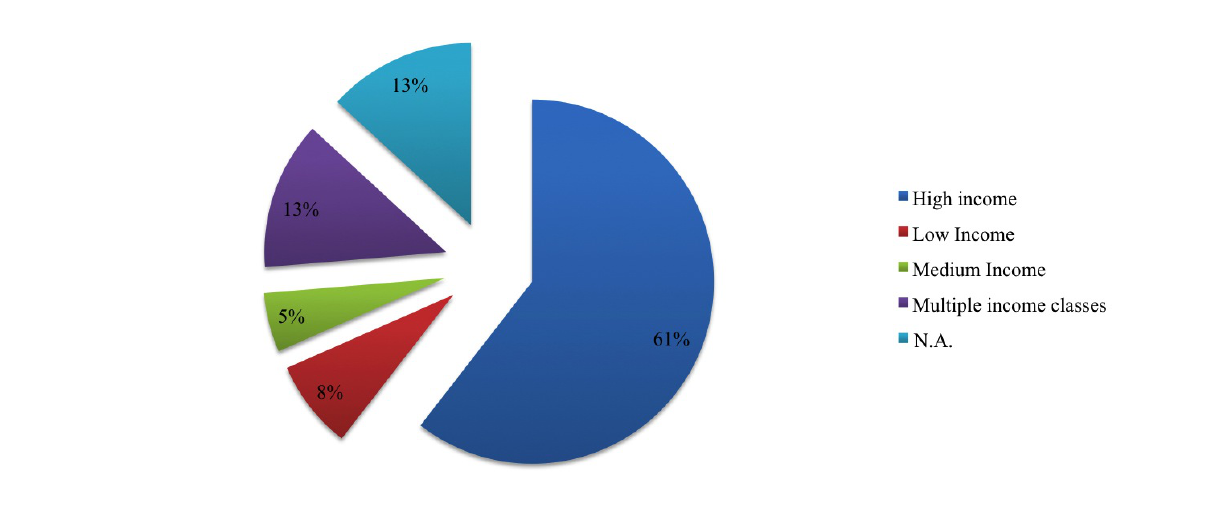
Figure 1. Type of